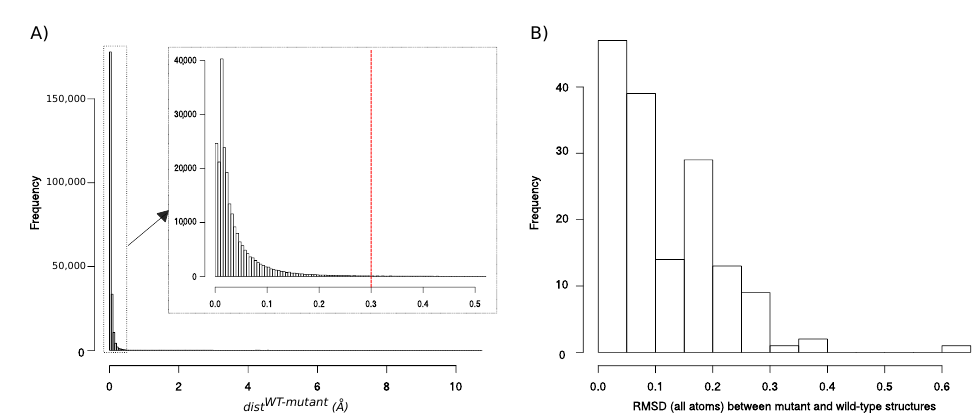
Figure A2. ( A ) Distribution of dist WT − mutant distances for each atom (hydrogen atoms were removed) in the set of 155 mutant structures. Red line corresponds the distance cutoff (0.3 Å) used to define an atom as shifted atom. ( B ) Distribution of RMSD (in Å) computed between wild-type and mutant structures. RMSD were computed using all